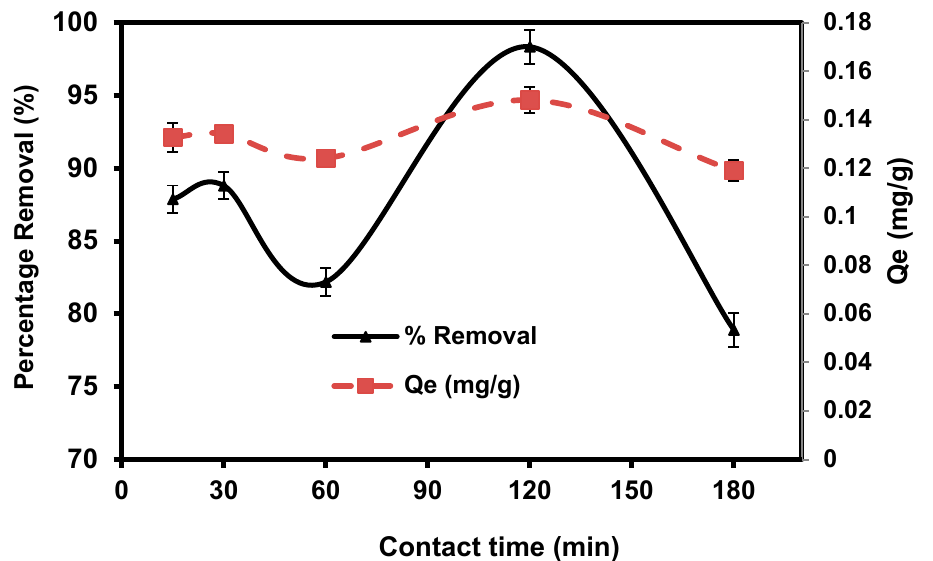
Figure 8. Impact of agitating time in the percentage removal of crystal violet dye.